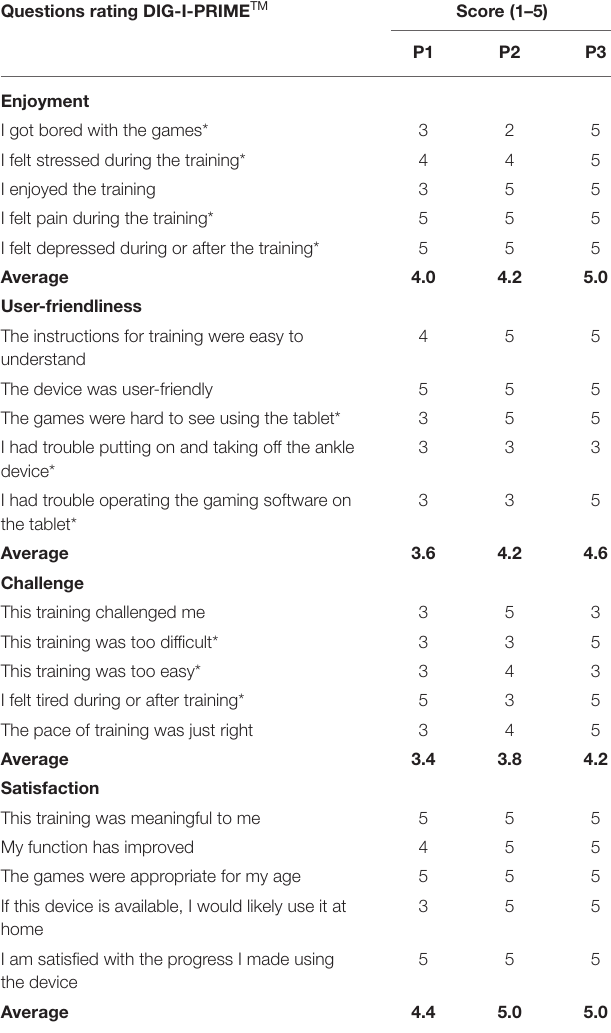
TABLE 1 | Participant acceptability of the DIG-I-PRIME TM